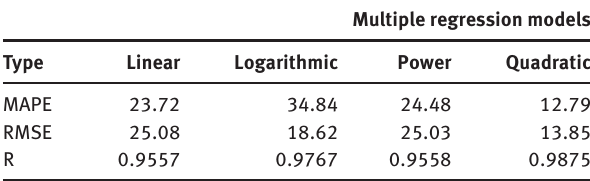
Table 7 Performance criteria of MR models.